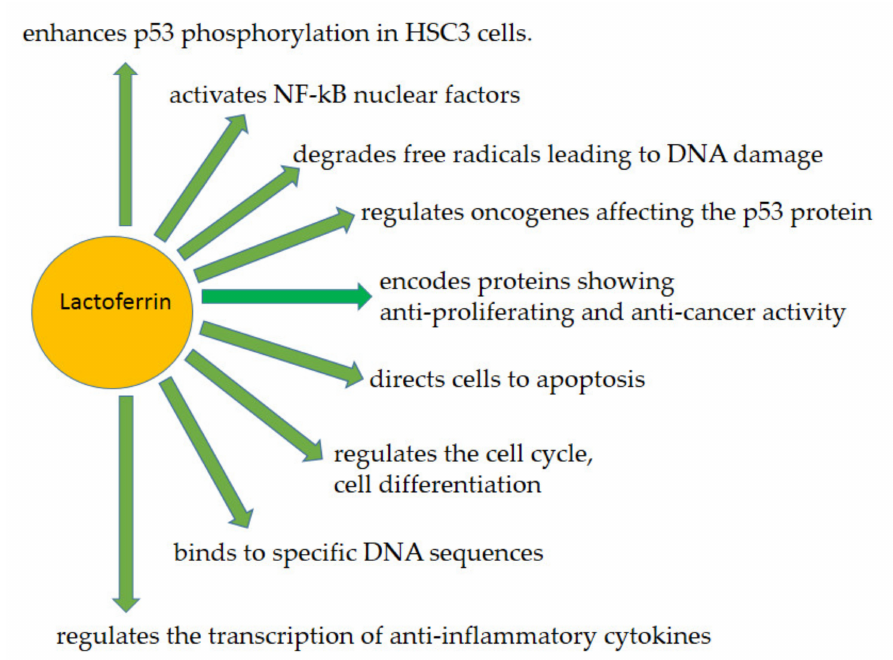
Figure 3. Lactoferrin direct action. LF acts as a multipotent protective factor both by acting on DNA, activating transcription factors, gene expression, regulating the cell cycle, differentiation and leading to the death of cells that threaten the body, such as cancer